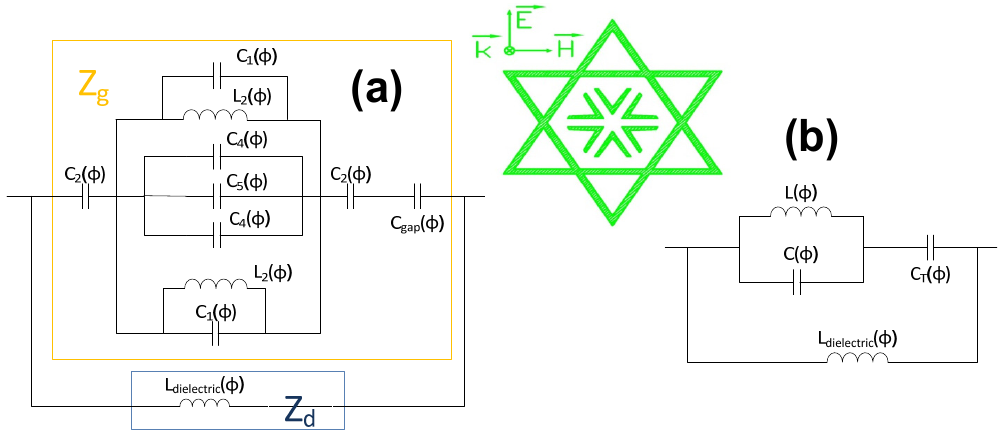
Figure 15. ( a ) Equivalent circuit for TM polarization and ( b ) its